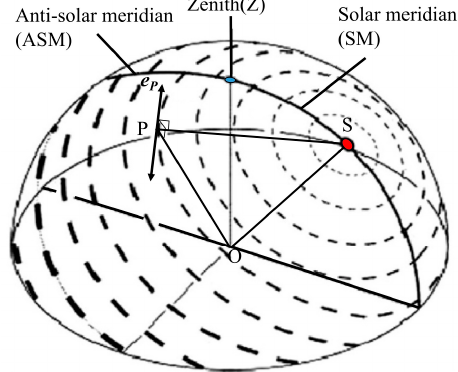
Figure 3. The 3D pattern of polarization in the sky. Orientation and width of the bars depict direction and degree of polarization. A remarkable pattern characteristic is that there is a symmetry line going through the Sun (S) and zenith (Z). On the side of the Sun it is called the solar meridian (SM) and on the opposite side it is called the anti-solar meridian (ASM) [11]. The point O denotes the position of the observer. The point P represents any position observed in the sky. The vector e P represents the maximum polarization direction of point P, which is a special vector with double direction.